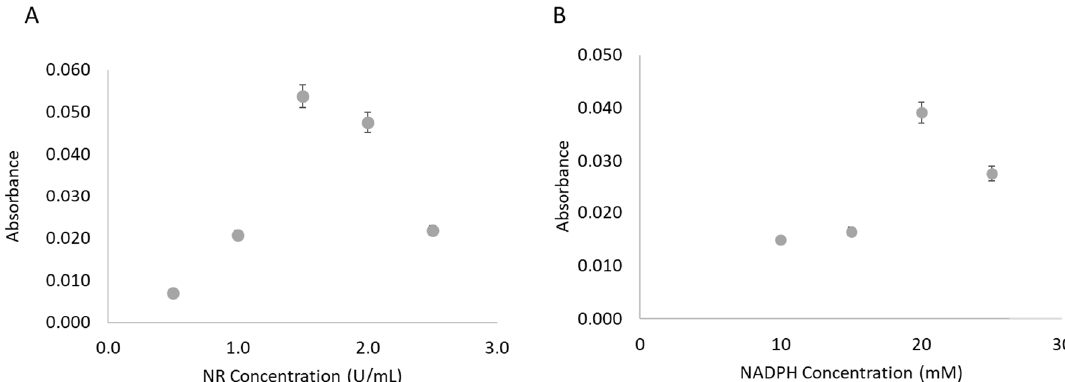
Figure 3. Study of the influence of the NR concentration ( A ) and NADPH concentration ( B ) on the enzymatic reduction reaction by calculation of the absorbance signal obtained for a 1.5 mM nitrate standard.